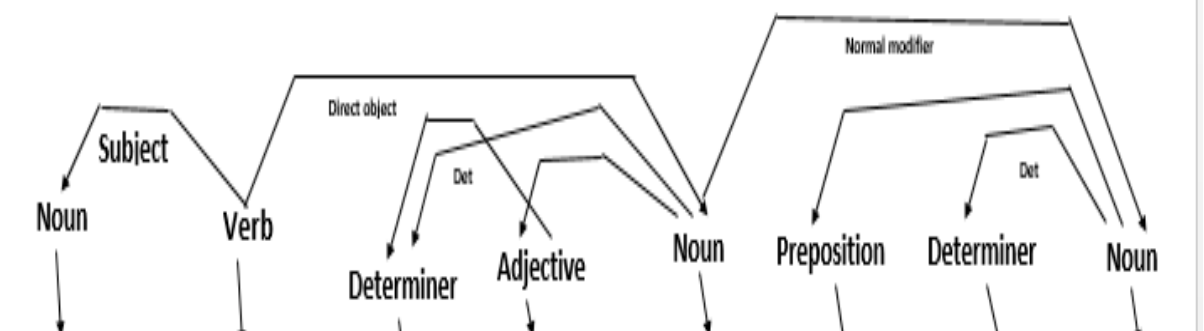
Figure 11. Text extraction and target customer base on word choice.